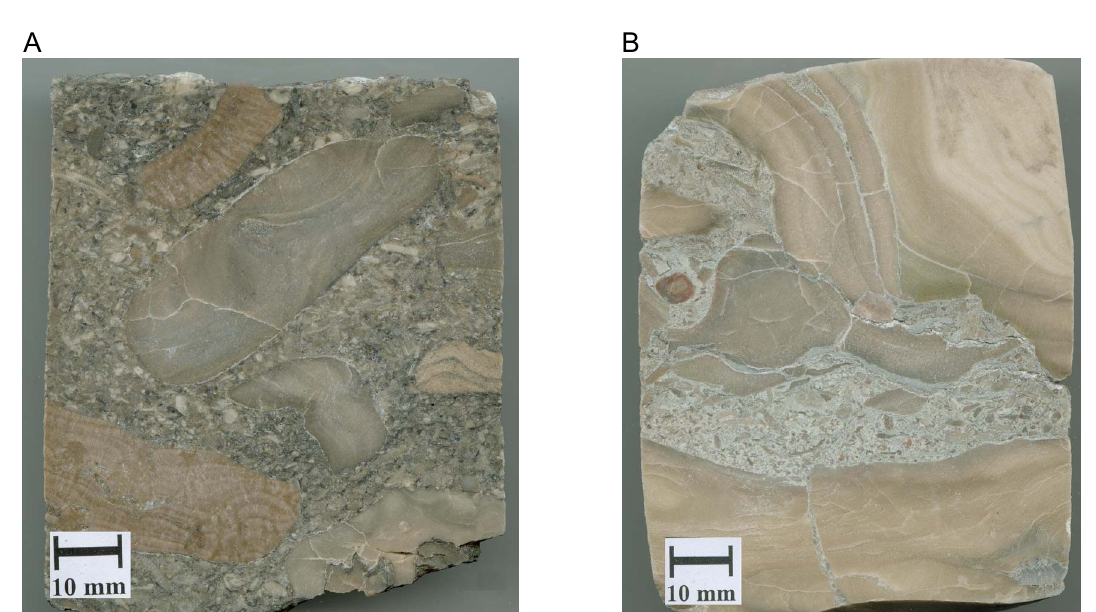
Fig. 7. Stromatoporoid coarse-grained limestone: A , Bliudziai 150 (sample depth 946.9 m); B , Bliudziai 152 (sample depth 946.1 m) wells (Bi č kauskas & Molenaar 2008b).